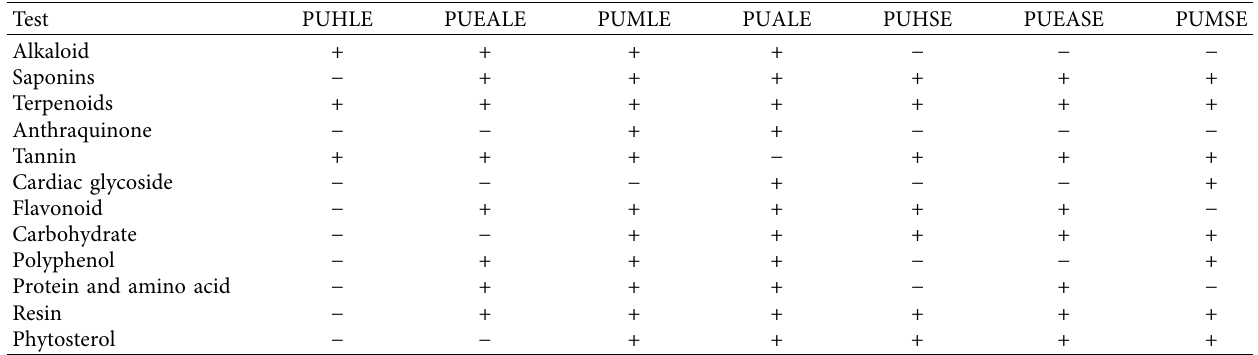
Table 2: Phytochemical screening of P. utilis extracts.